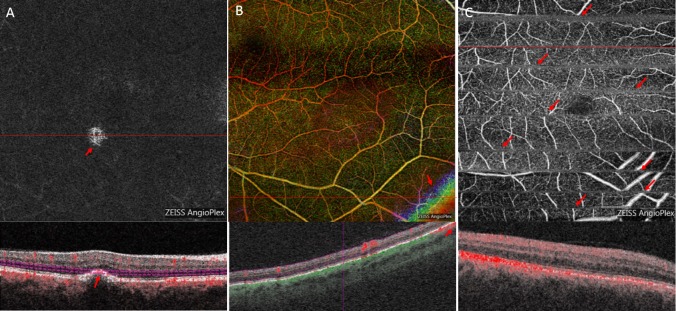
Examples of artifacts.For each artifact OCTA enface and B-Scans are shown. Red arrows indicate the artifacts, red lines indicate the corresponding B-scan. (A) segmentation artifact retina avascular layer. (B) out of window artifact retina layer depth encoded. (C) motion artifact retina layer.